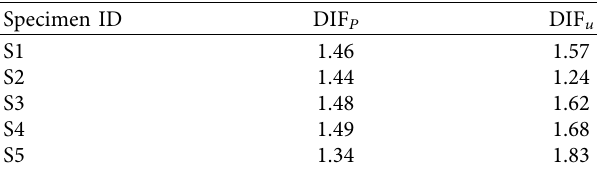
Figure 12: Relationship between DIFs and vertical displacement. Table 4: DIFs at different loading